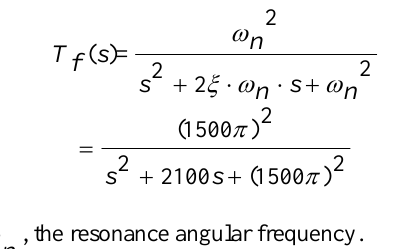
Figure 5. Protection design implemented in